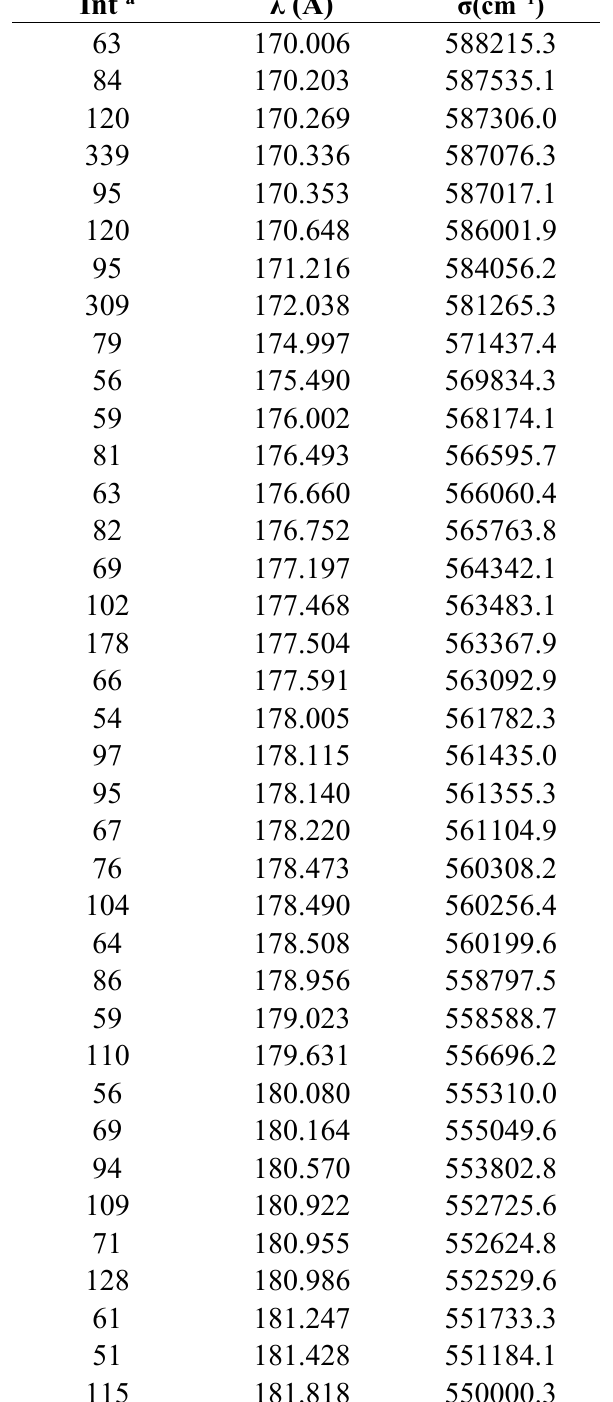
Table 4. Lines of W IX excited in a vacuum spark with intensities greater than 50 a